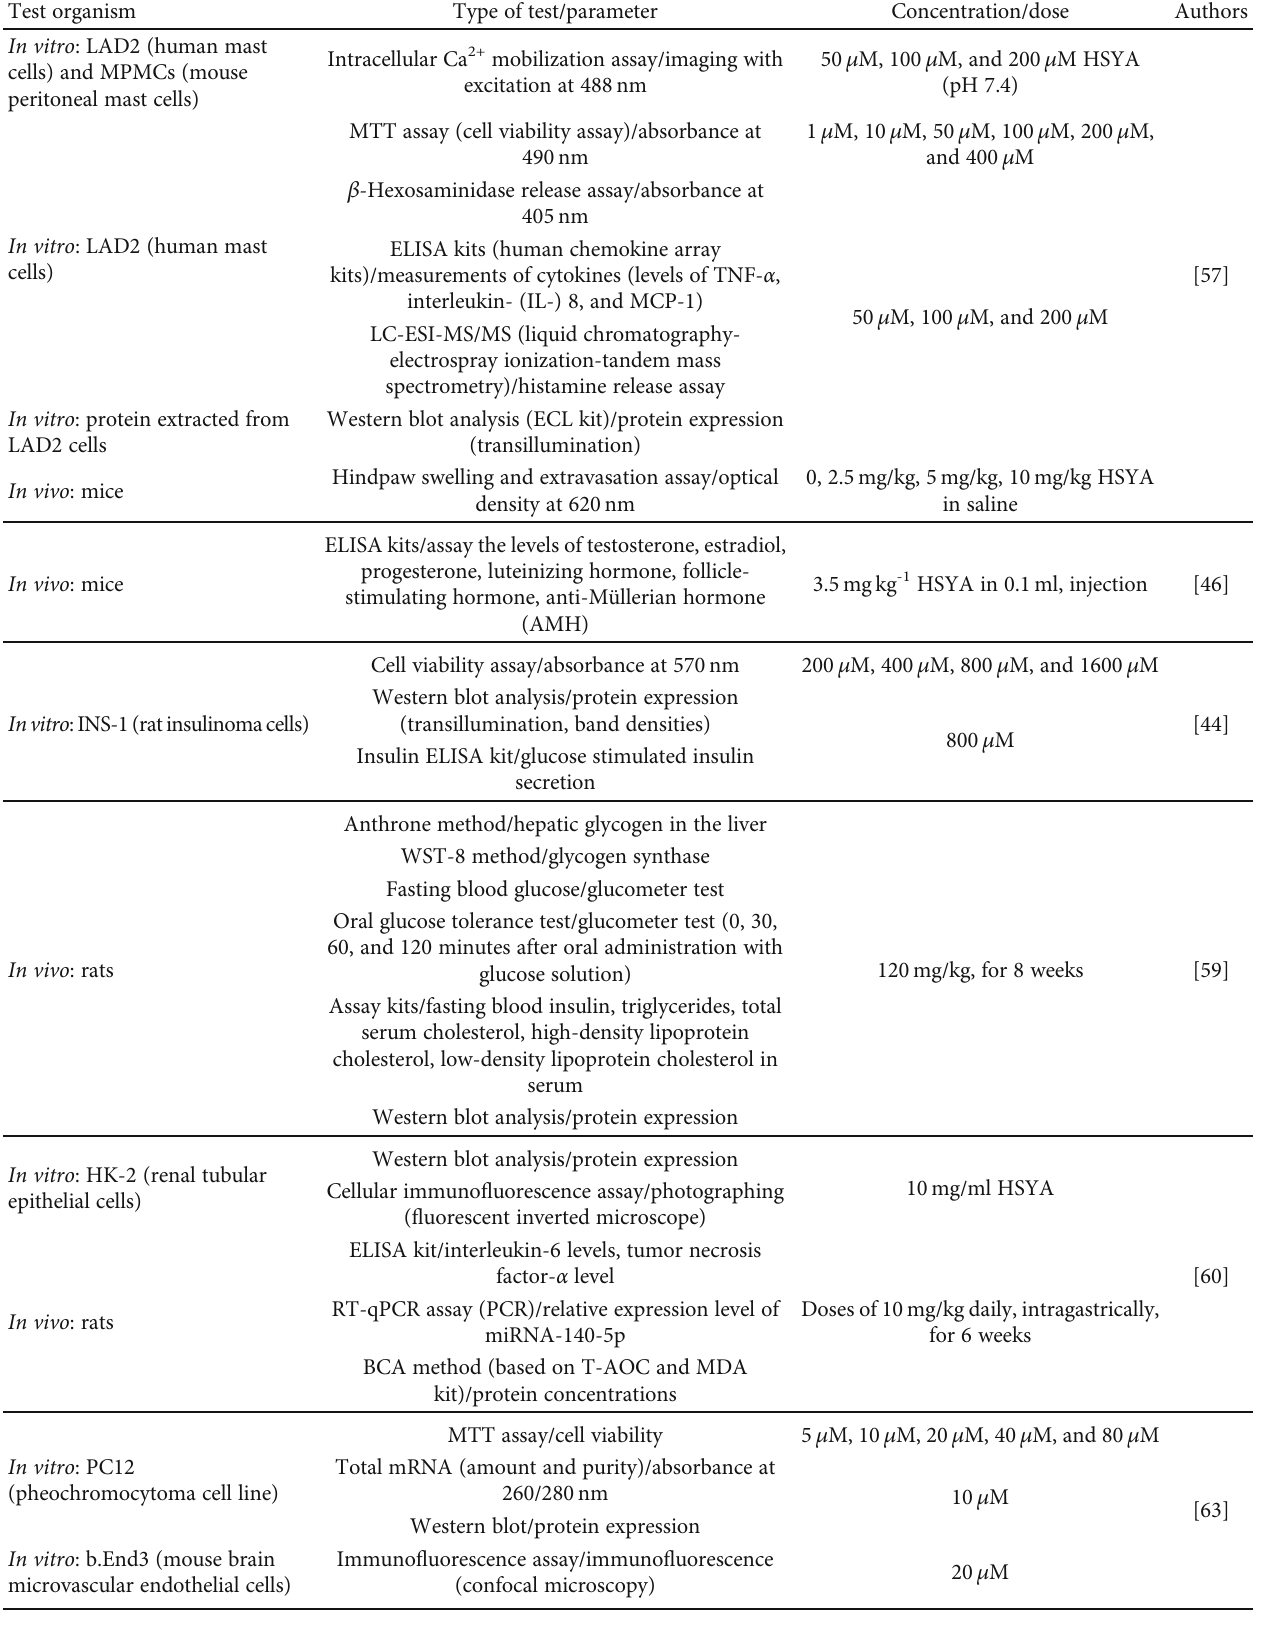
Table 3: Studies on the use of HSYA for medical purposes (from 2018 to 2020).